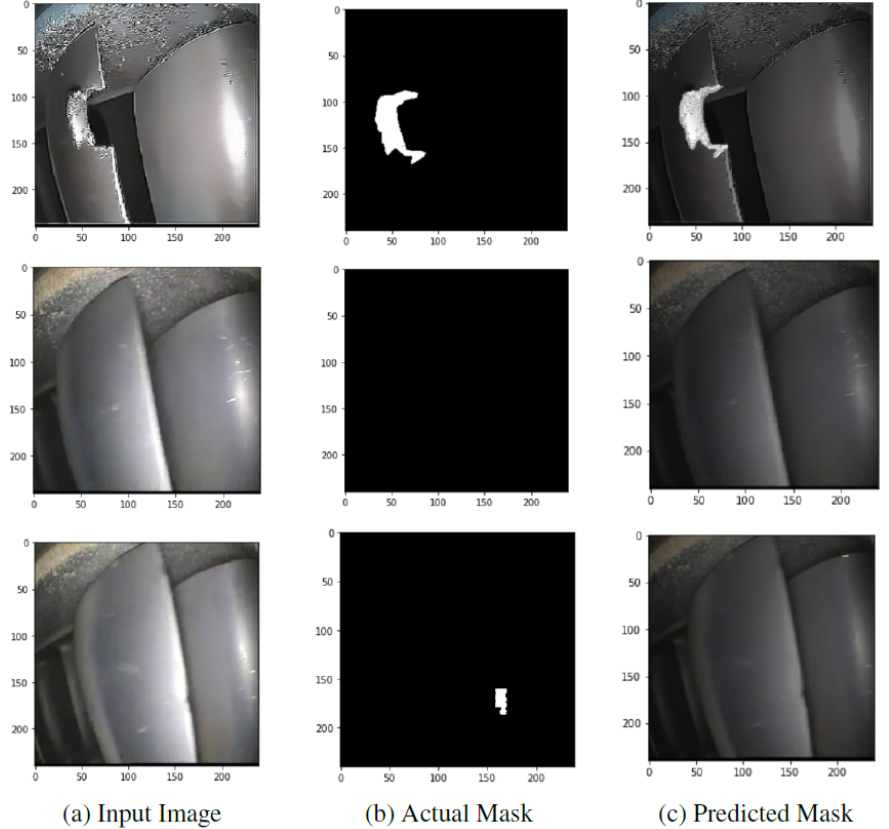
Figure 12. TL segmentation on test data after 300